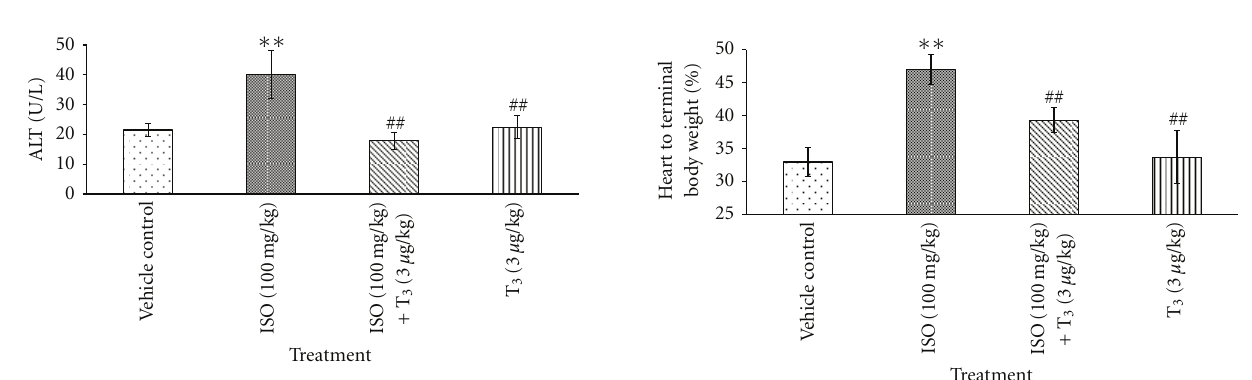
Figure 2: E ff ect of T 3 on ALT, values are presented as Mean ± SD, n = 5, ∗∗ : significant from control group at 1% level ( P < 0 . 01), ## : significant from ISO control at 1% level ( P < 0 . 01), SD: Standard Deviation.